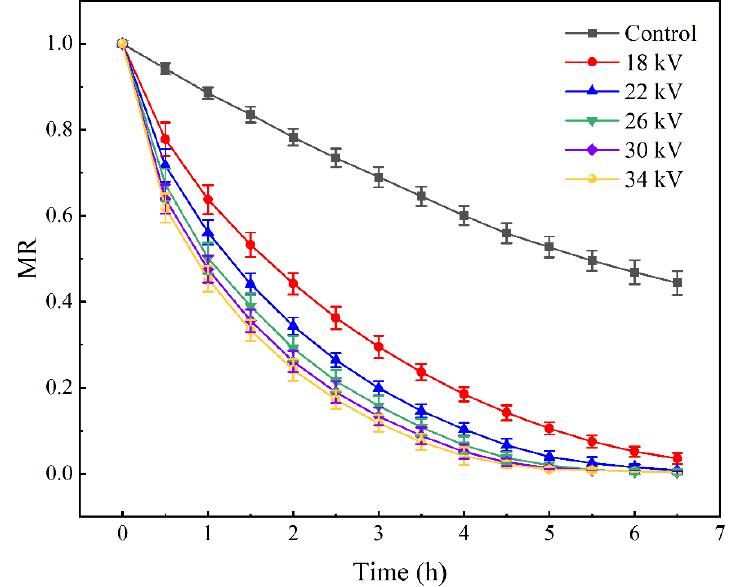
Figure 2. Curve of the moisture content of shiitake mushroom